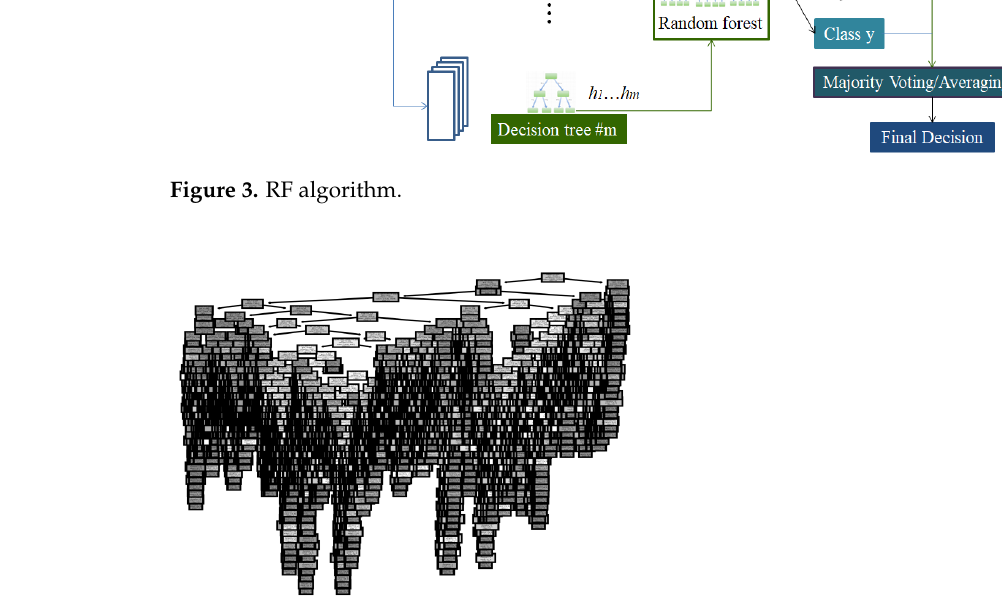
Figure 3. RF algorithm.